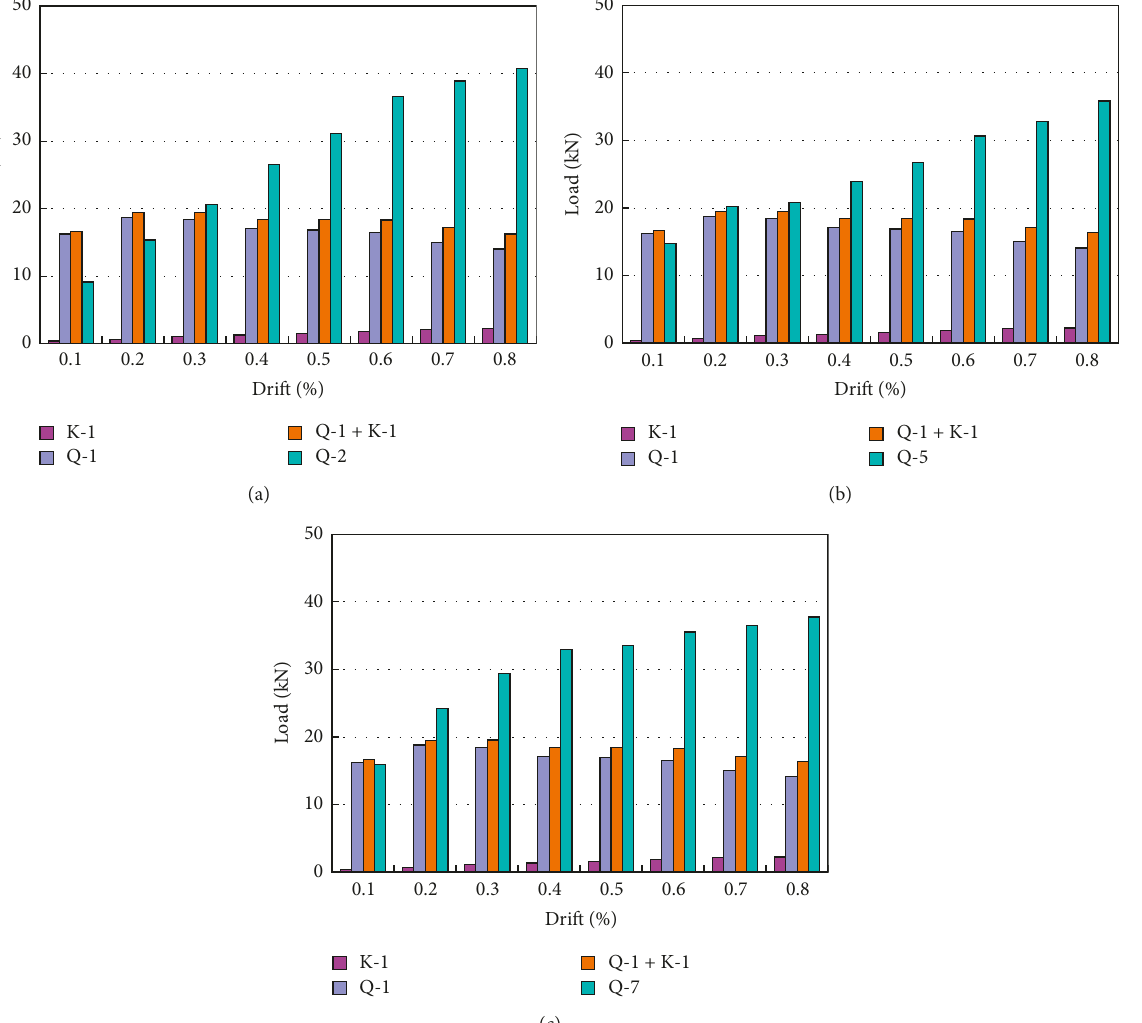
Figure 12: Comparison of strength of specimens at specific drifts. Comparison of strength between (a) Q-2 and Q-1; (b) Q-5 and Q-1; (c) Q-7 and